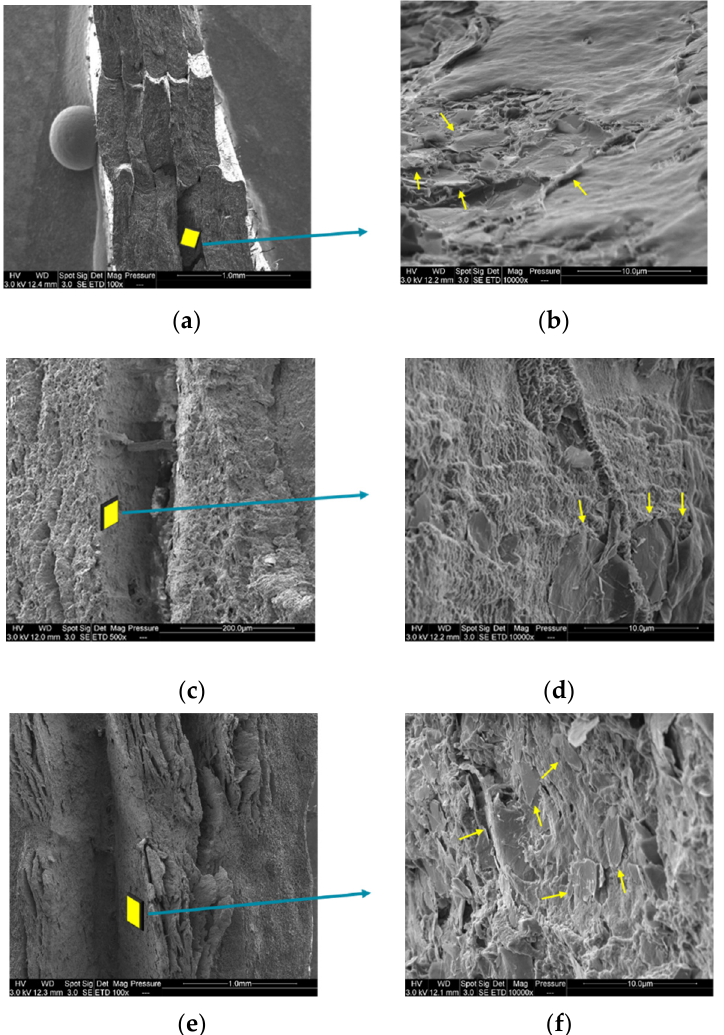
Figure 10. ( a , c , e ) SEM images at the interface of two 3D printed filaments of PLA/PCL/15 wt.% M5 composites; ( b , d , f ) the zoomed images of ( a ), ( c ), and ( e ), respectively (the yellow arrows are pointed composites; ( b , d , f ) the zoomed images of ( a , c , e ), respectively (the yellow arrows are pointed towards towards some graphene nanoplatelets). some graphene